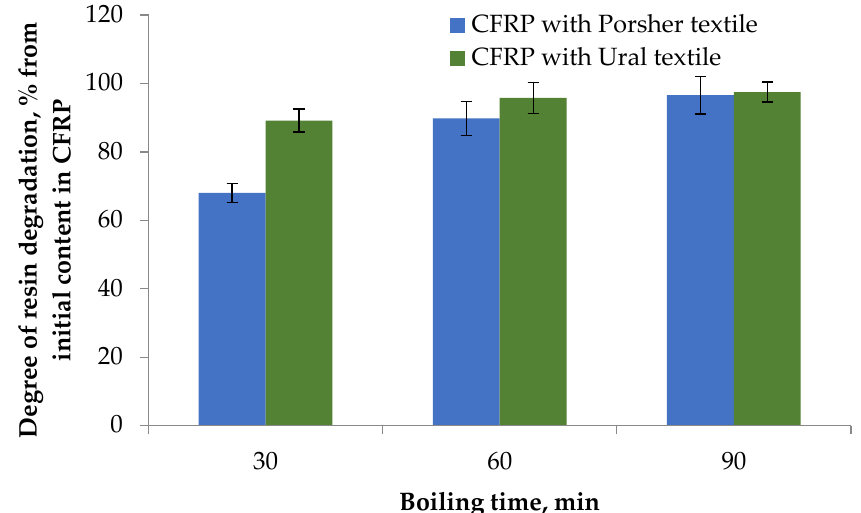
Figure 3. Resin breakdown efficiency vs. duration of the process.